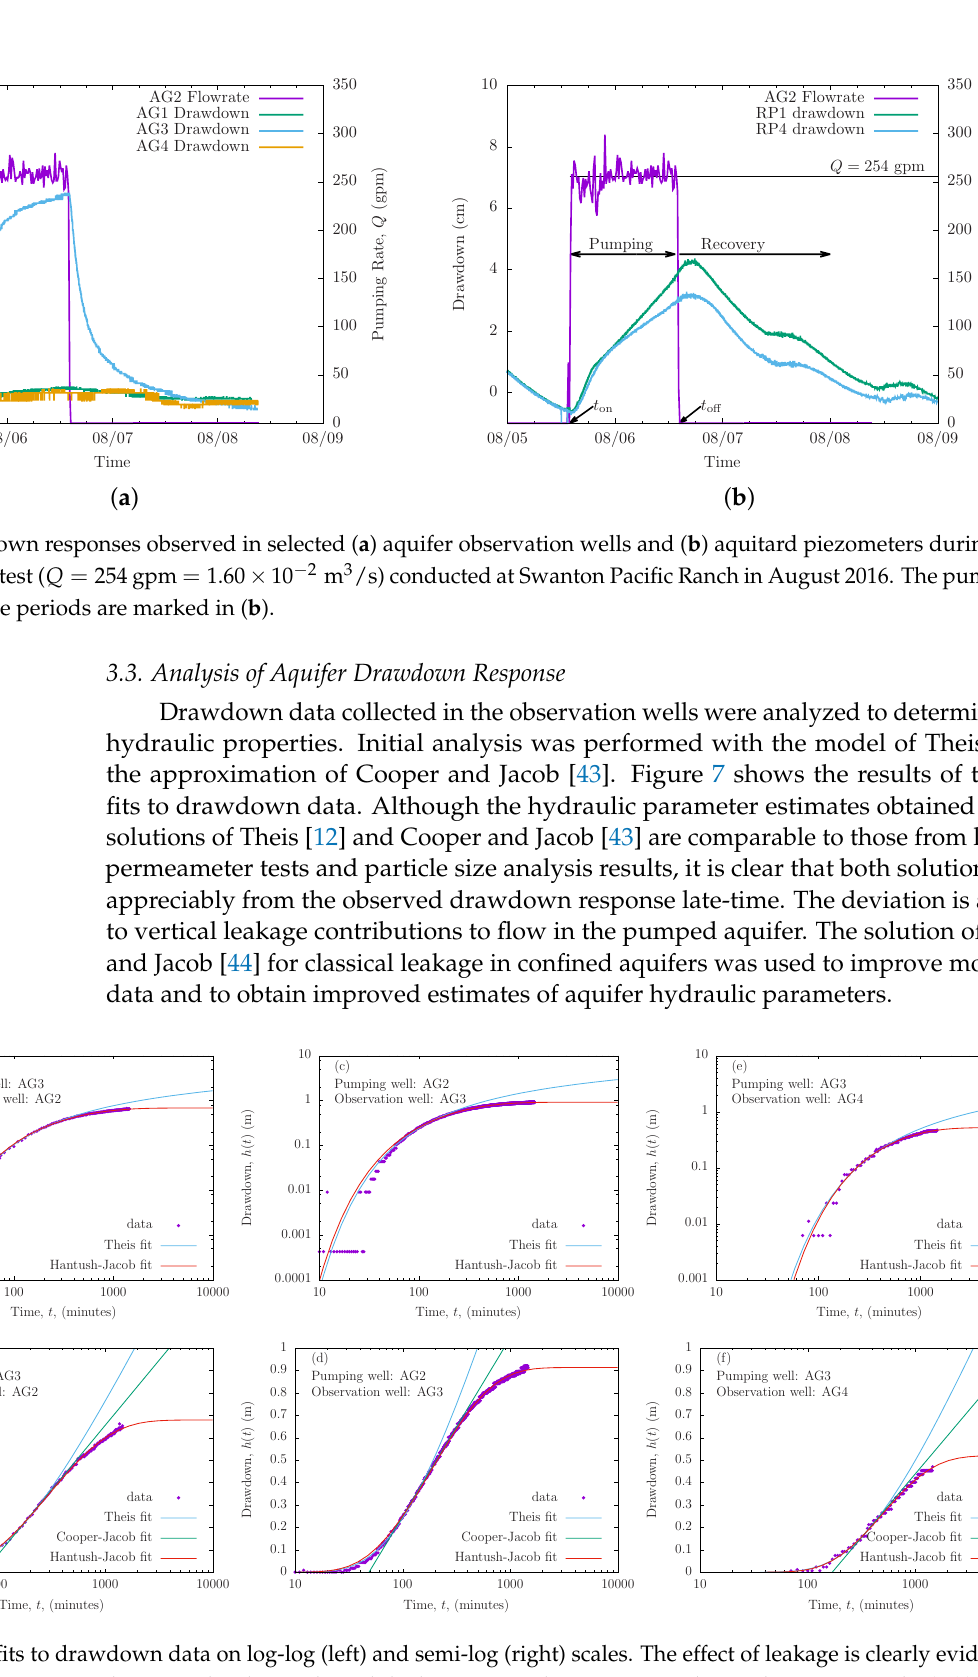
Figure 7. Model fits to drawdown data on log-log (left) and semi-log (right) scales. The effect of leakage is clearly evident at late-time. Here the top graphs are on log-log scale and the bottom graphs are on semi-log scale. Respectively, ( a , b ) show drawdown in well AG2 due to pumping in well AG3, ( c , d ) drawdown in AG3 due to pumping in AG2, and ( e , f ) drawdown in AG4 due to pumping in